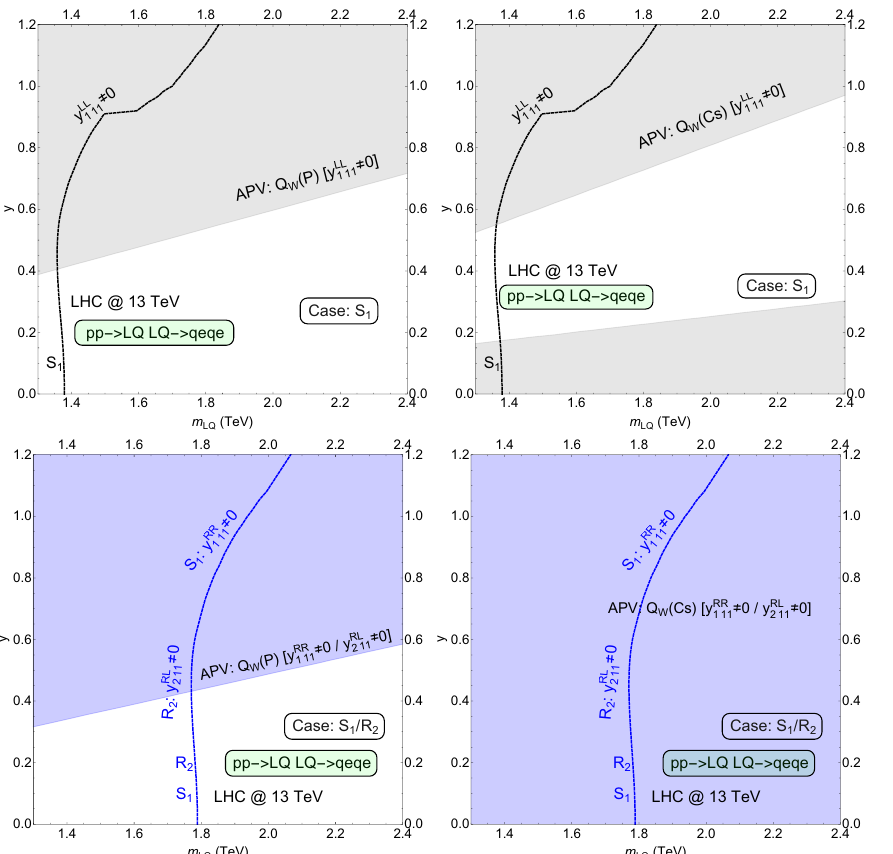
Figure 11 . APV limits for the proton (left) and Cs (right) measurements juxtaposed with the leptoquark pair production search limits for the corresponding leptoquark scenarios, as indicated. Shaded regions are ruled out by the APV